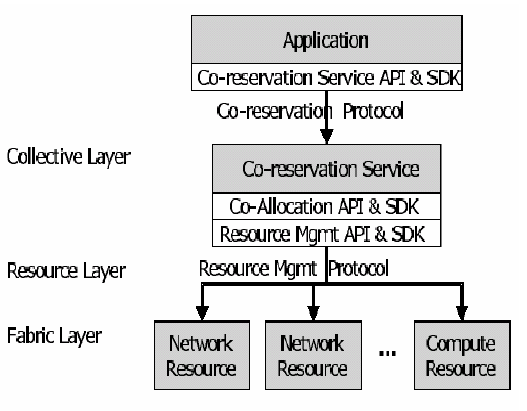
Figure 10: Collective and Resource layer protocols, services, APIs, and SDKS can be combined in a variety of ways to deliver functionality to applications. [4]